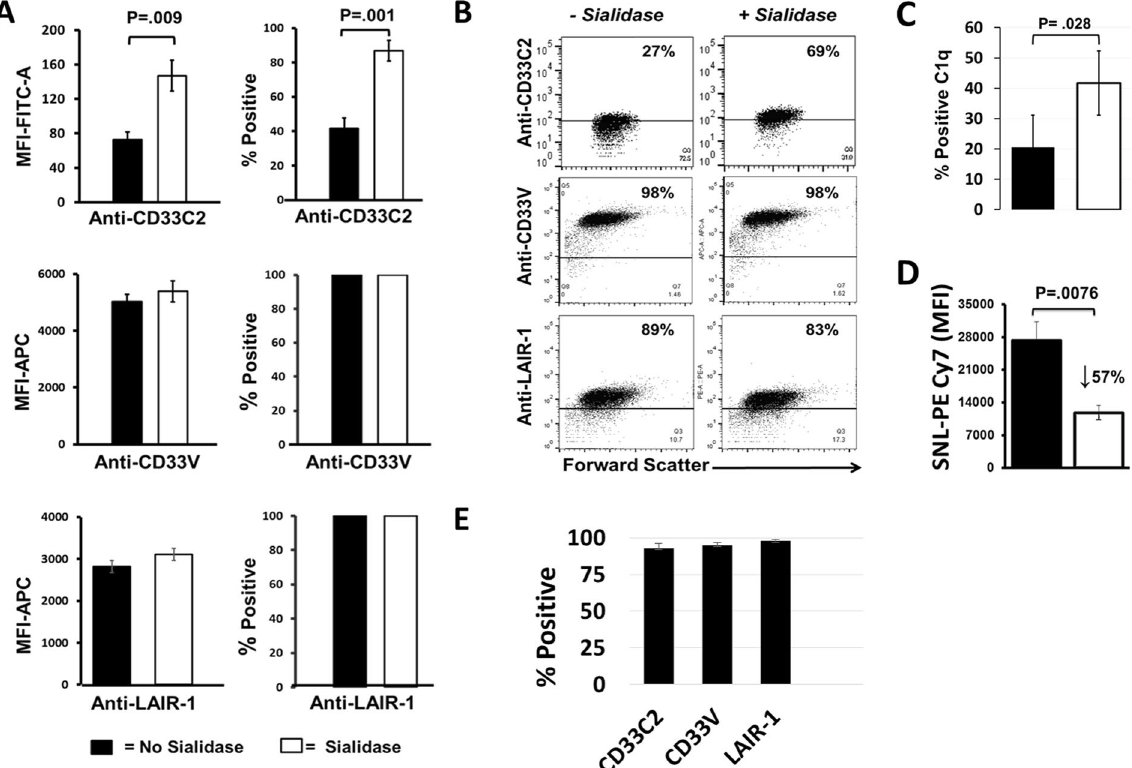
Figure 4. Masking of CD33C2 domains impedes C1q binding on the cell surface. ( A , B ) Increased detection of the CD33C2, but not the CD33V domain or LAIR-1, occurs after sialidase treatment of THP-1 cells. Cells were treated with sialidase (20 mU/10 6 cells) for 60 min at 37 °C in a humidified incubator, resuspended twice in PBS, then in staining buffer for detection of CD33C2 domains (HIM3-4), CD33V domains (WM53) and LAIR-1. A = Pooled data, N ≥ 4. B = Representative experiment from A; gates were set according to isotype Ab controls. ( C ) Unmasking of CD33C2 domains with sialidase correlates with increased binding of C1q on THP-1 cells; N = 3–4. ( D ) Reduced levels of sialic acid on the THP-1 surface after sialidase treatment as revealed by decreased binding to Sambucus nigra lectin (SNL) (5 ug/ml). N = 5. ( E ) Pooled flow cytometry data showing highly expressed CD33C2 and CD33V domains and LAIR-1 on freshly isolated normal monocytes. Results represent mean + / − SEM. N = 3–4. For ( A , C , D ) solid bars = no sialidase; open bars = sialidase. Two-tailed Student’s t test was used to determine